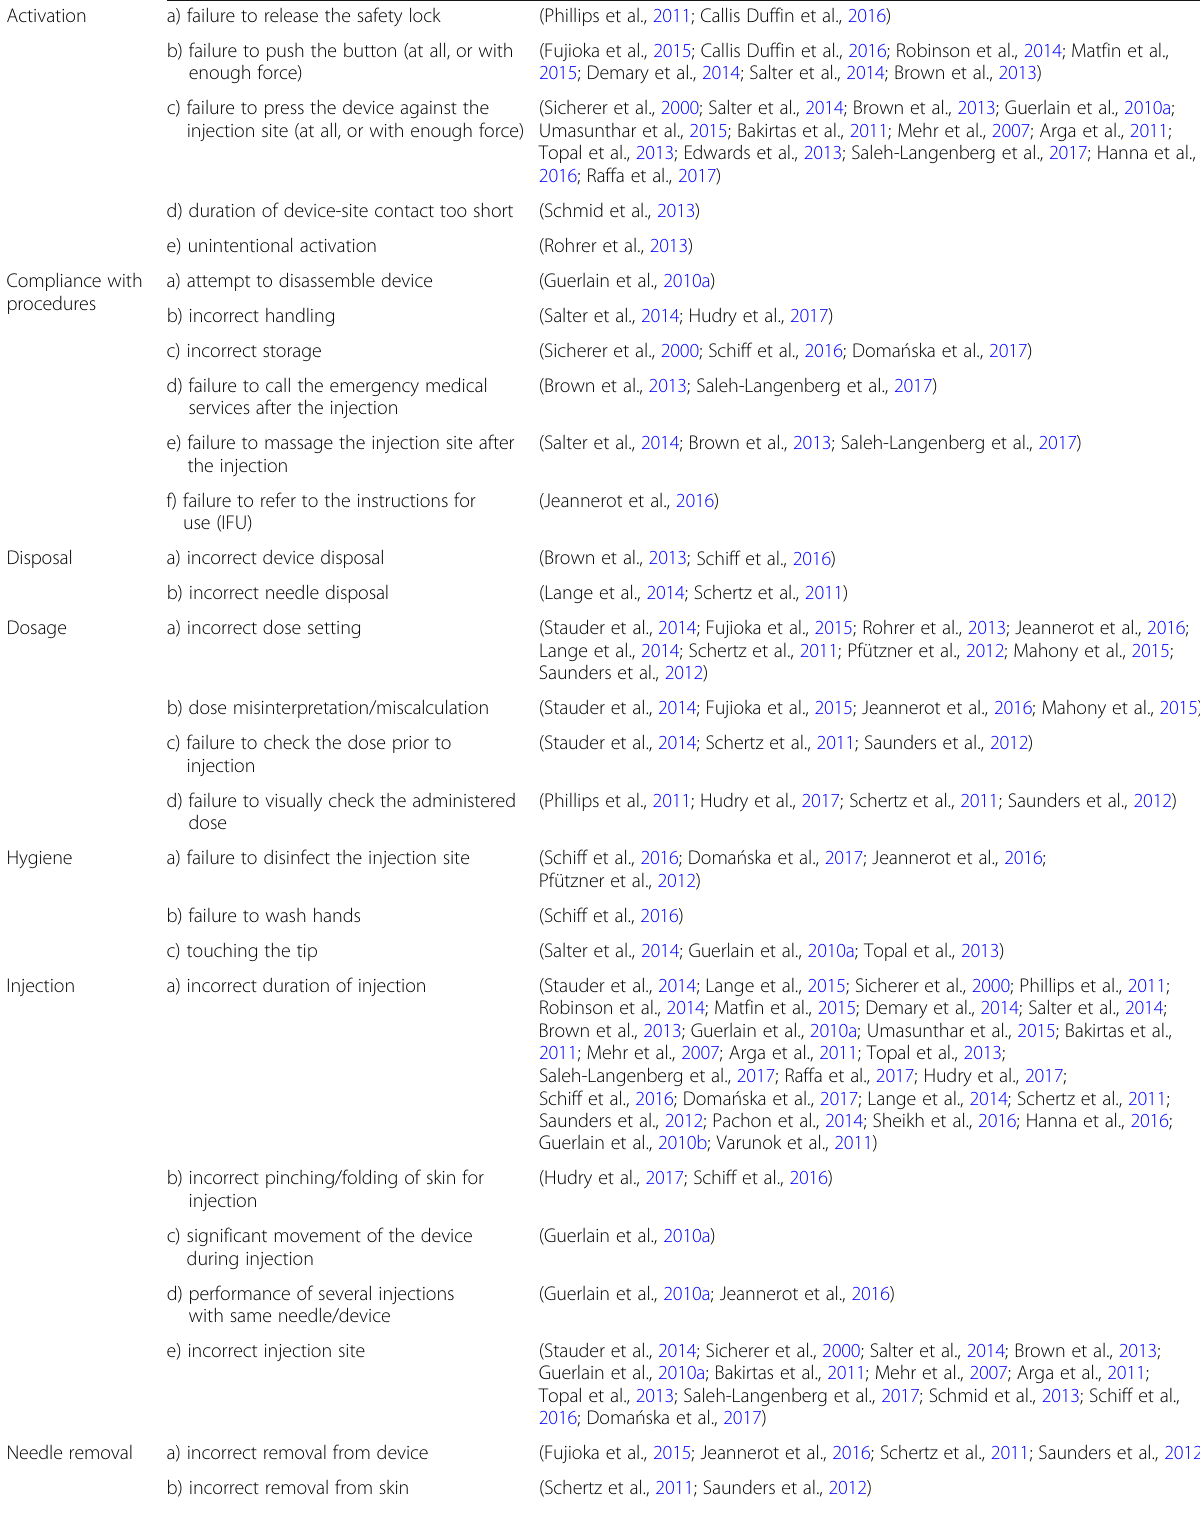
Table 1 Categories of use errors and close